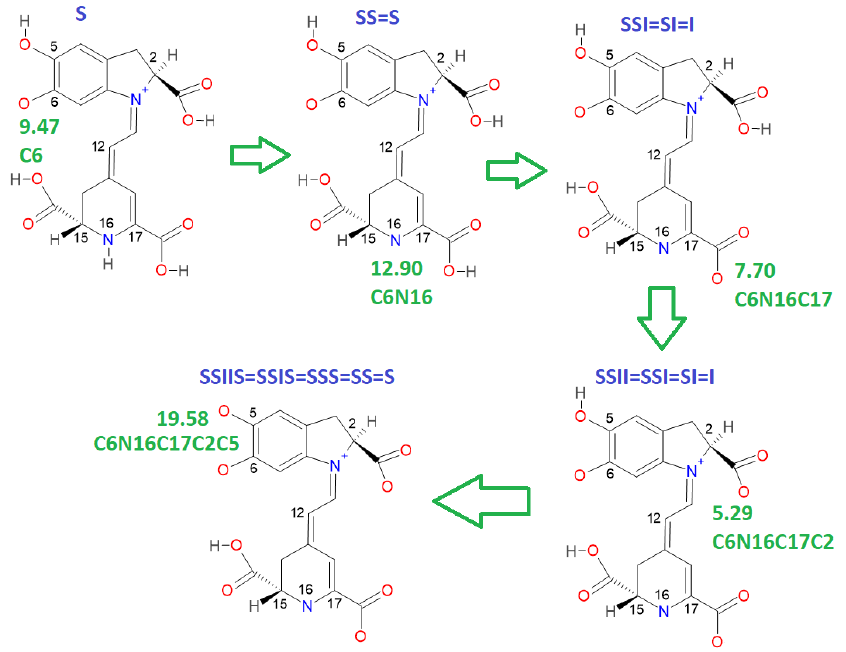
Figure 7. Cluster prediction location of a fifth deprotonation route starting with a very high pK a ; the evolution in the rounds clearly jumps between superior and inferior clusters. According to the statement proved in Section 2.2, if the last deprotonation includes a hydroxyl group or NH16, then the route is placed in the superior cluster; otherwise, if the last deprotonation belongs to a carboxyl group, then the route is in the inferior cluster of low pK a .